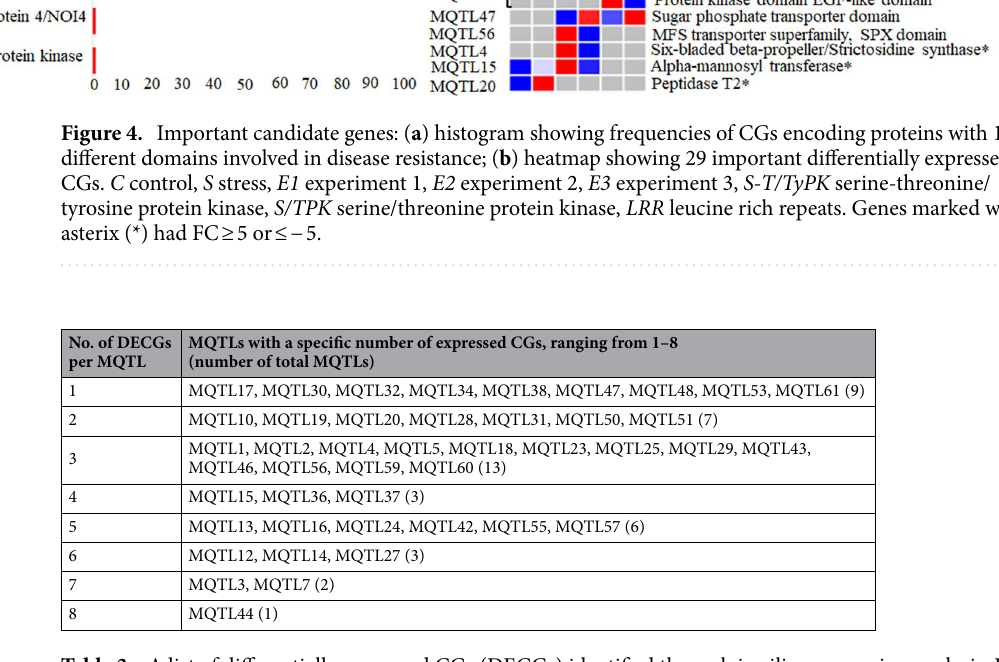
(Fig. 4a and Supplementary Table S3) and (ii) 144 differentially expressed CGs (DECGs), belonging to 44 MQTLs, based on in silico expression analysis (Supplementary Table S4). Twenty-four (24) CGs were common among the above two categories of genes (Table 3, Supplementary Tables S3 and S4).